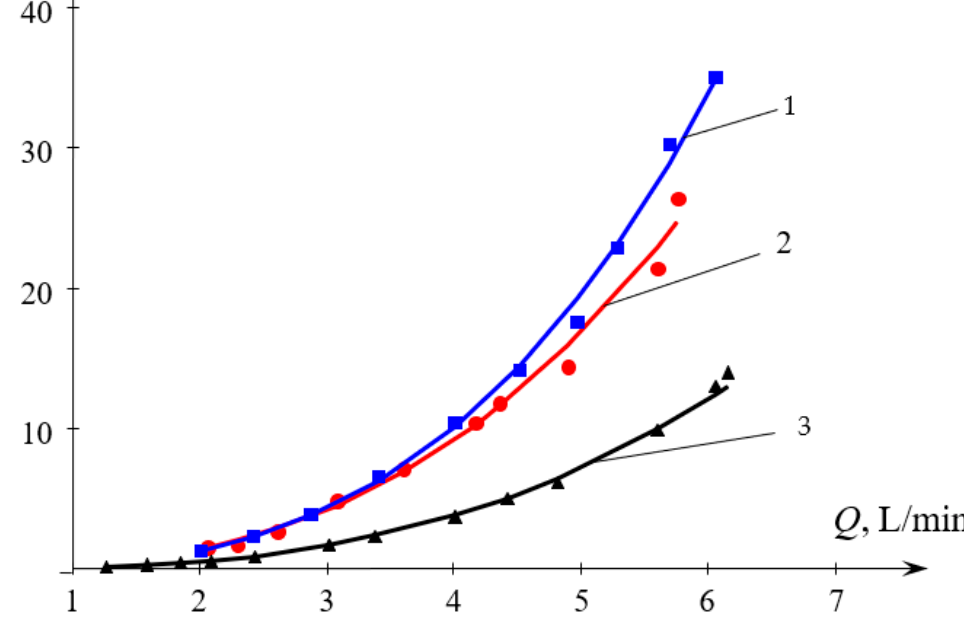
Figure 7. Dependence of the specific energy dissipation rate on the total flow rate ( Q = Q 2 = Q 1 a + Q 1 b ) for liquids supplied through the upper tangential and lower tangential branch pipes (TU1, TL2). Points—experimental data, line—dependence ε = 0.074 Q 2.846 ( Q is in L/min, ε is in kW/kg).